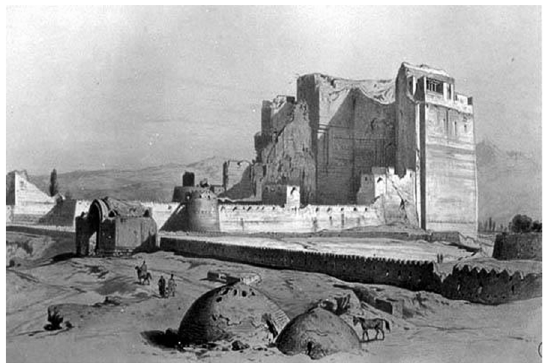
Fig. 4 The ruins of the Arg-e Alishah in Tabriz, drawn by Pascal Coste in the nineteenth century (Source: Pakzad 2011,